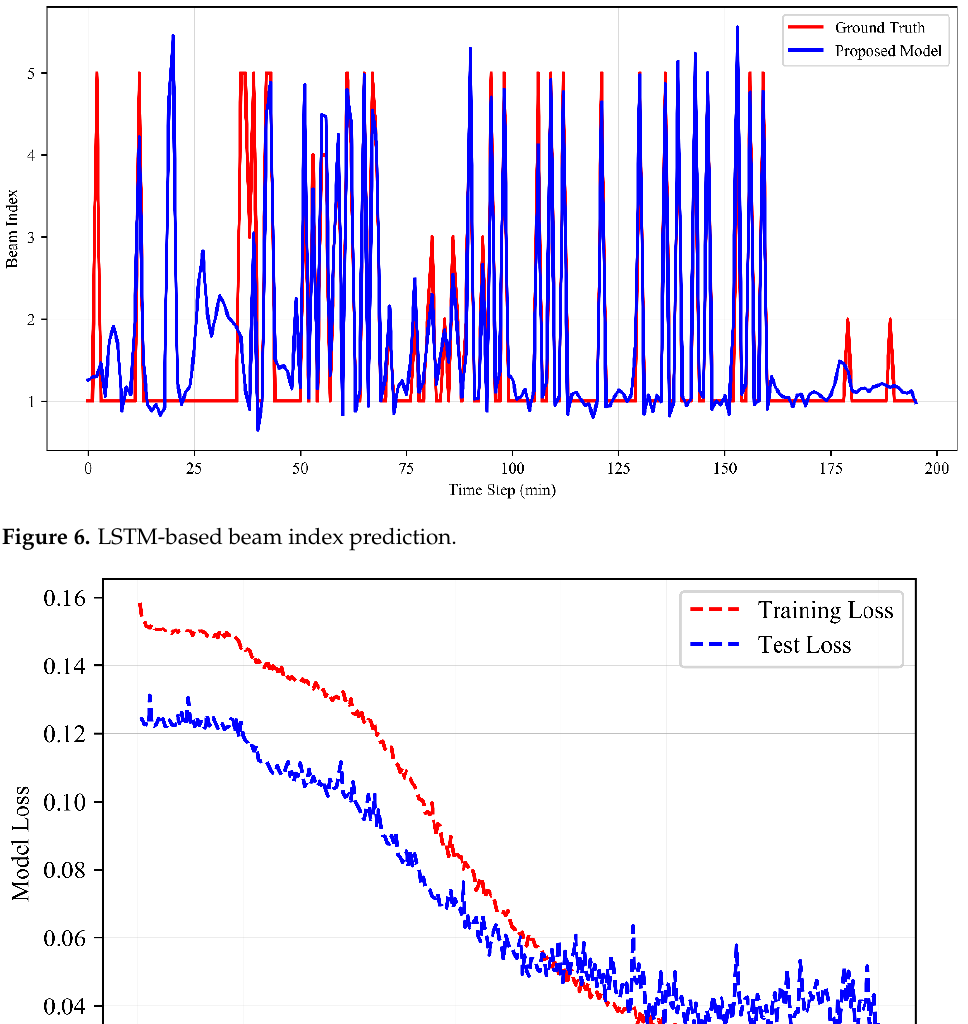
Table 7. System parameters.